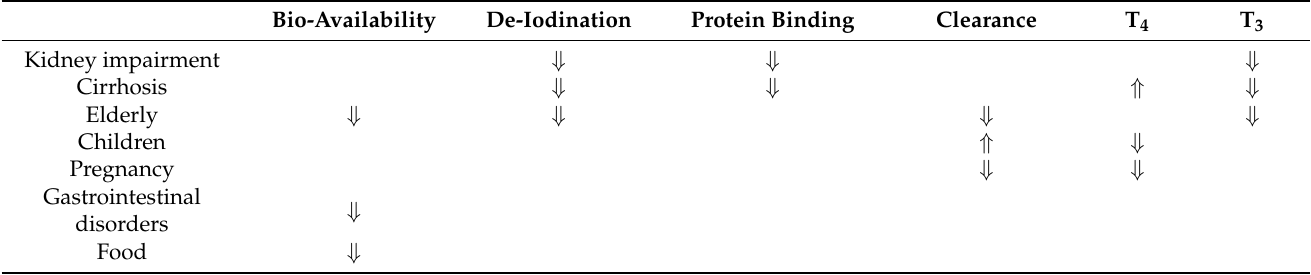
Table 1. Pharmacokinetics of levothyroxine in special populations